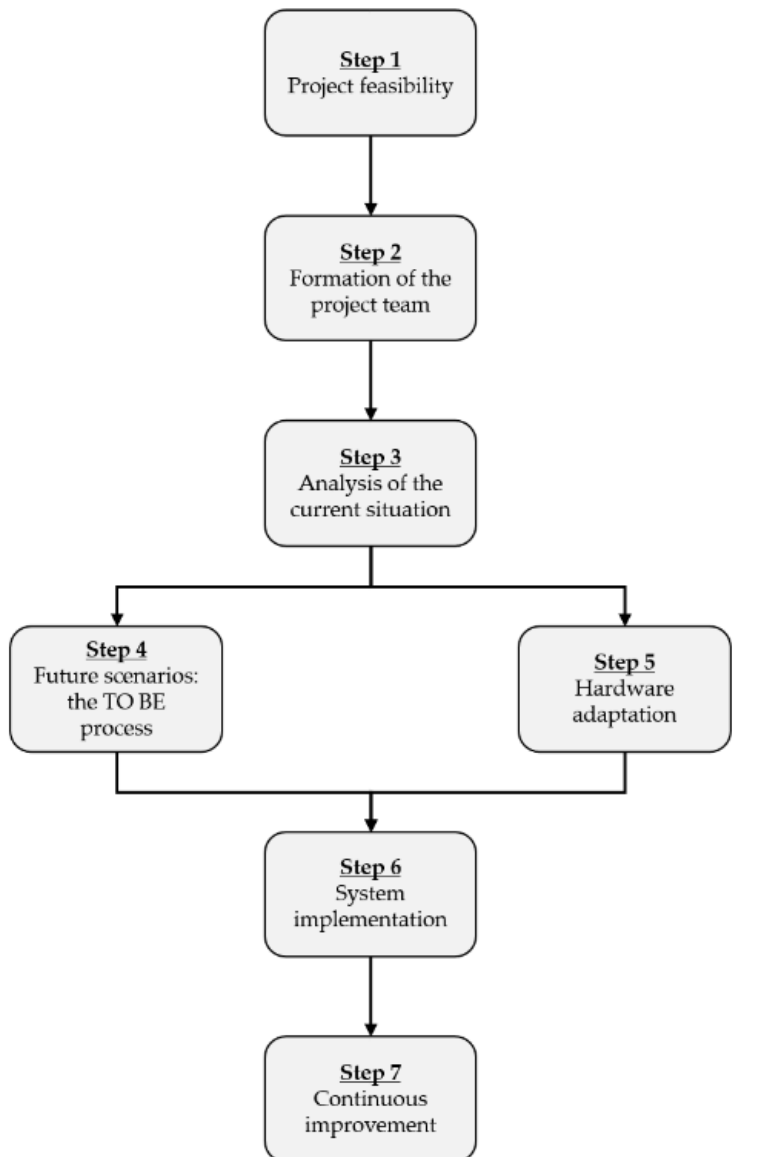
Figure 3. Model framework for implementing traceability systems based on AIDC technologies (adapted from [8]).